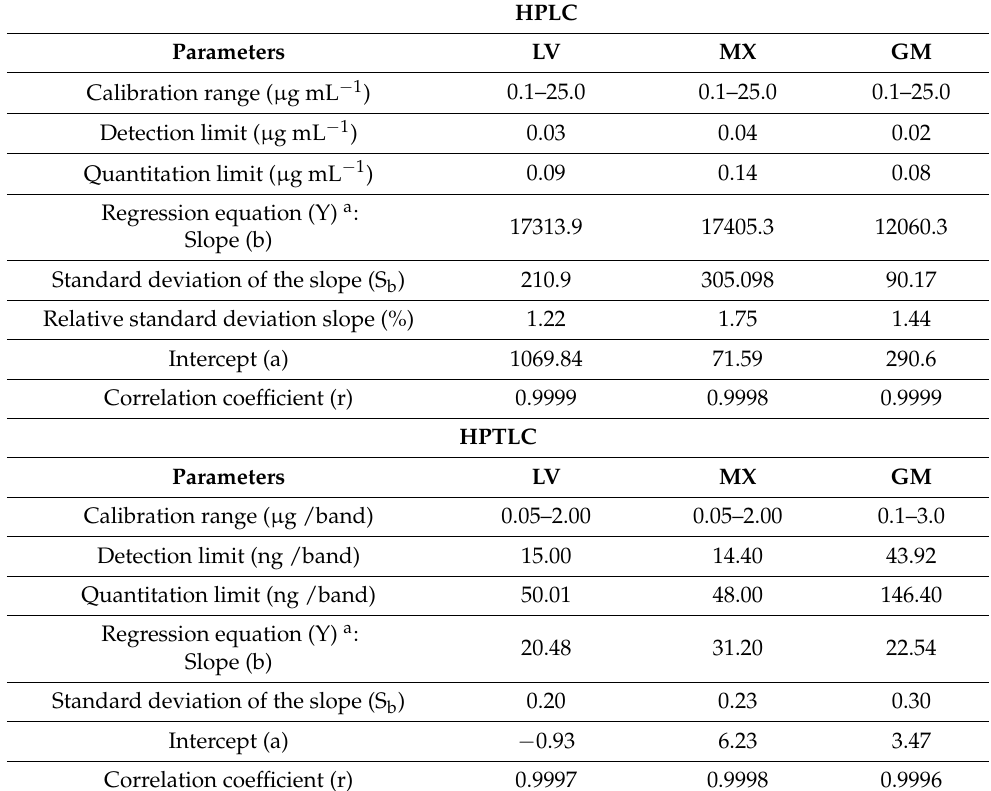
Table 2. Characteristic parameters of the calibration equations for the developed HPLC and HPTLC methods for determination of the selected